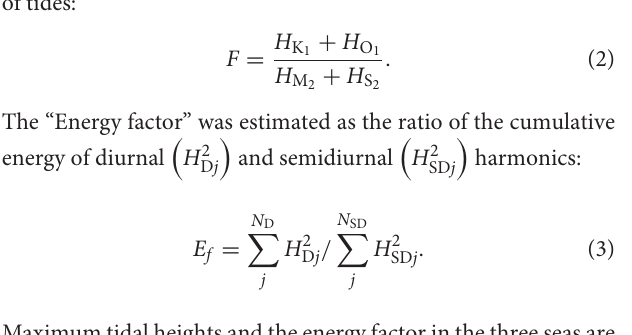
Frontiers in Marine Science |